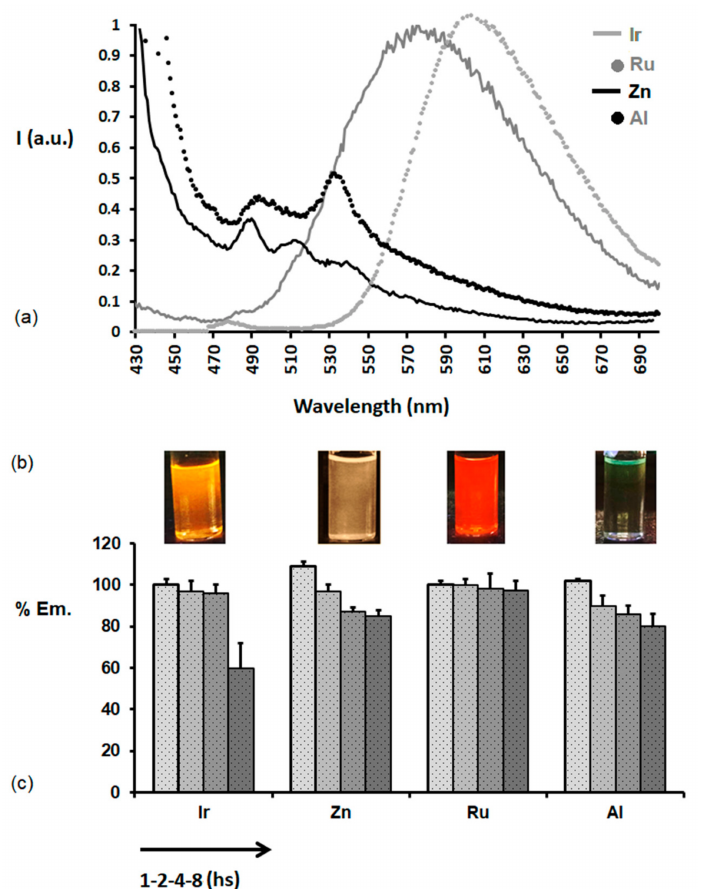
Figure 2. ( a ) emission spectra of complexes in f/2 Guillard medium at t = 0; ( b ) images of solutions of complexes in DMSO/f/2 Guillard medium; ( c ) variation of percentages of maximum photolumi- nescence intensity of complexes’ solutions recorded at 0, 1, 2, 4, and 8 h time intervals. Bar error refers to triplicates.